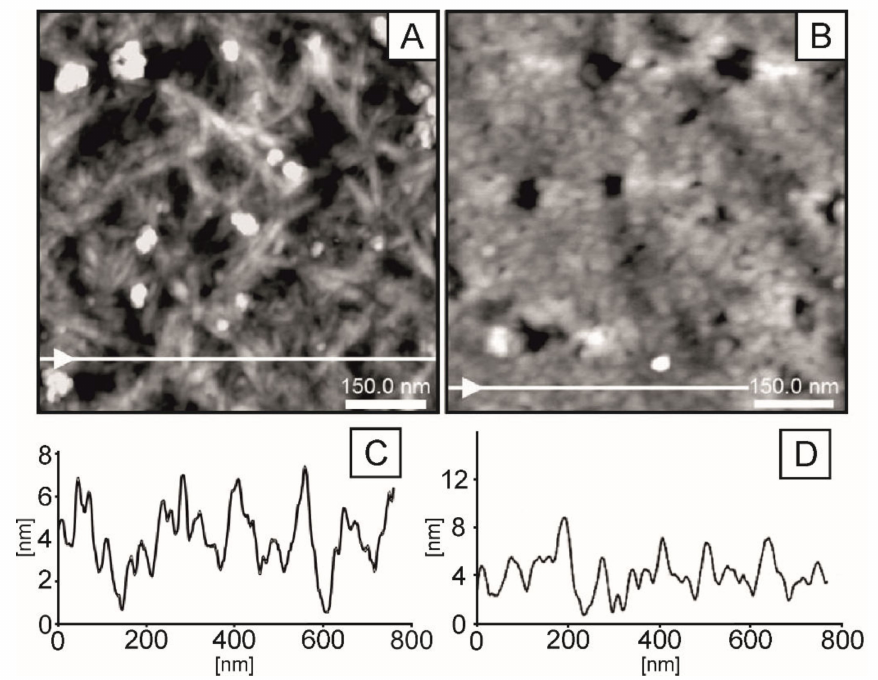
Figure 6. AFM images ( A , B ) and line profiles ( C , D ) of β -1,3- D -glucan ( A , C ) and chitosan ( B , D ) polymeric films. Scanning area: ( A , B ) 750 × 750